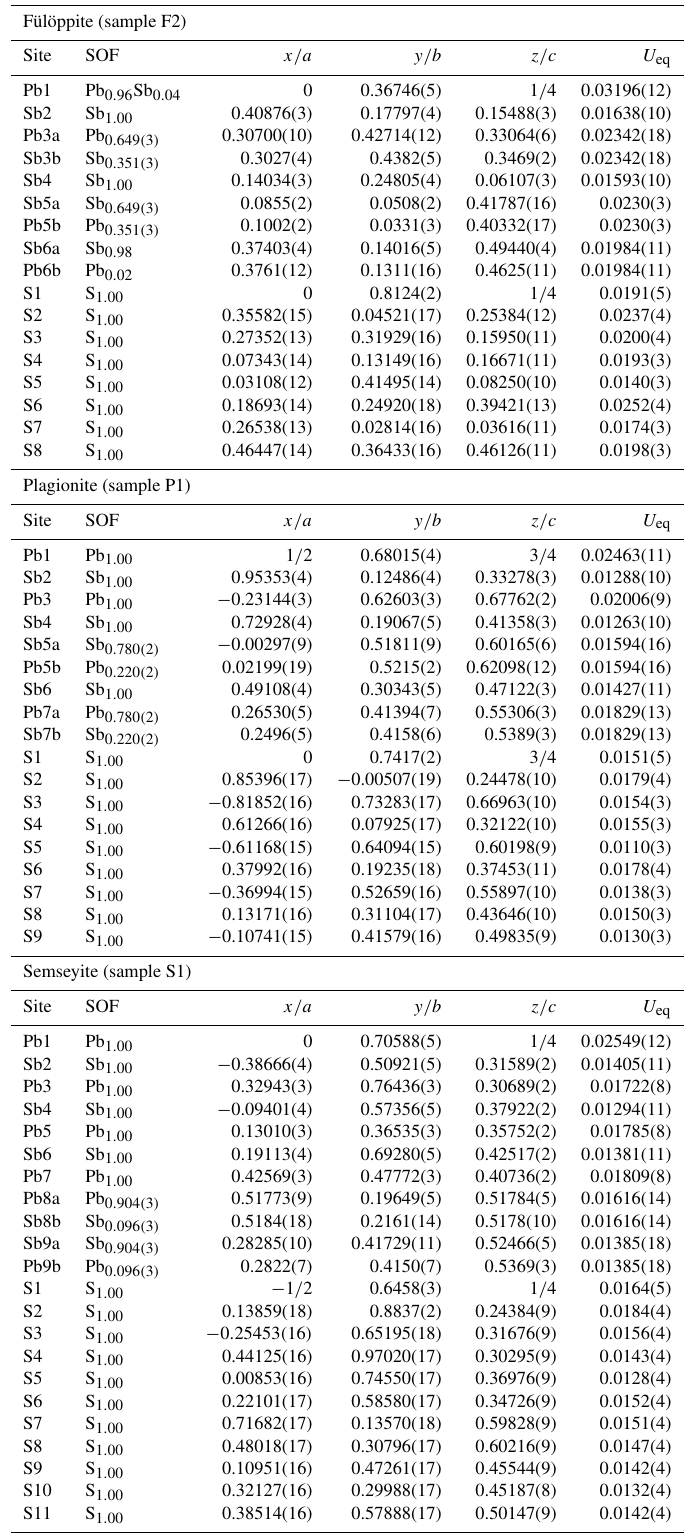
Table 2. Sites, site occupancy factors (SOFs), fractional atomic coordinates, and equivalent isotropic displacement parameters (Å 2 ) for selected samples of fülöppite, plagionite, and